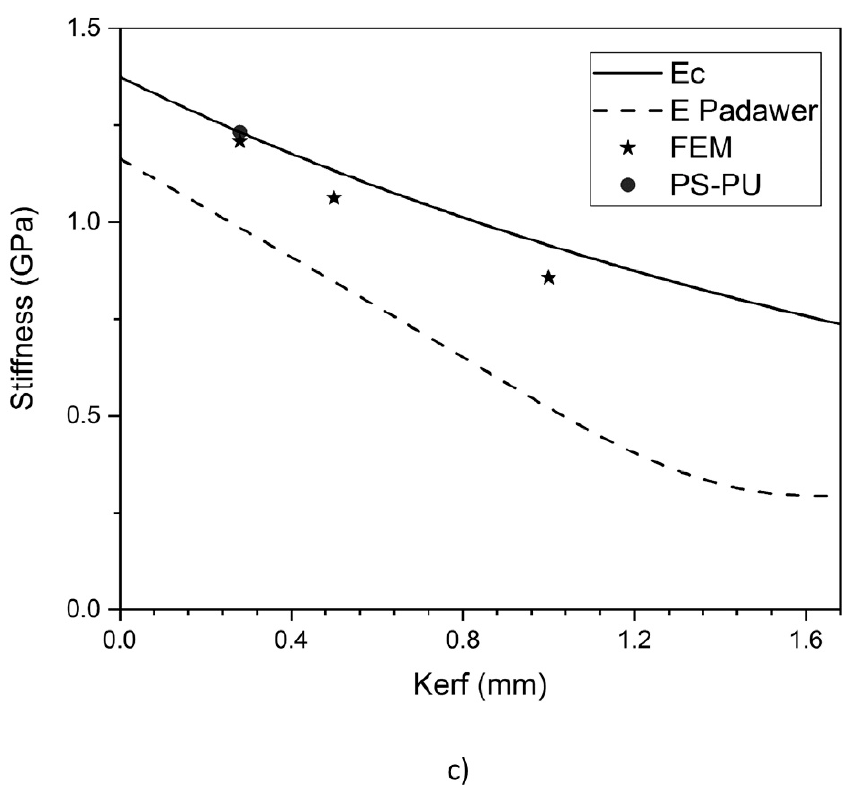
Figure 5. Processing influence on hexagonal composite stiffness, ( a ) Matrix thickness, ( b ) Hexagonal short diagonal, ( c ) cut width.